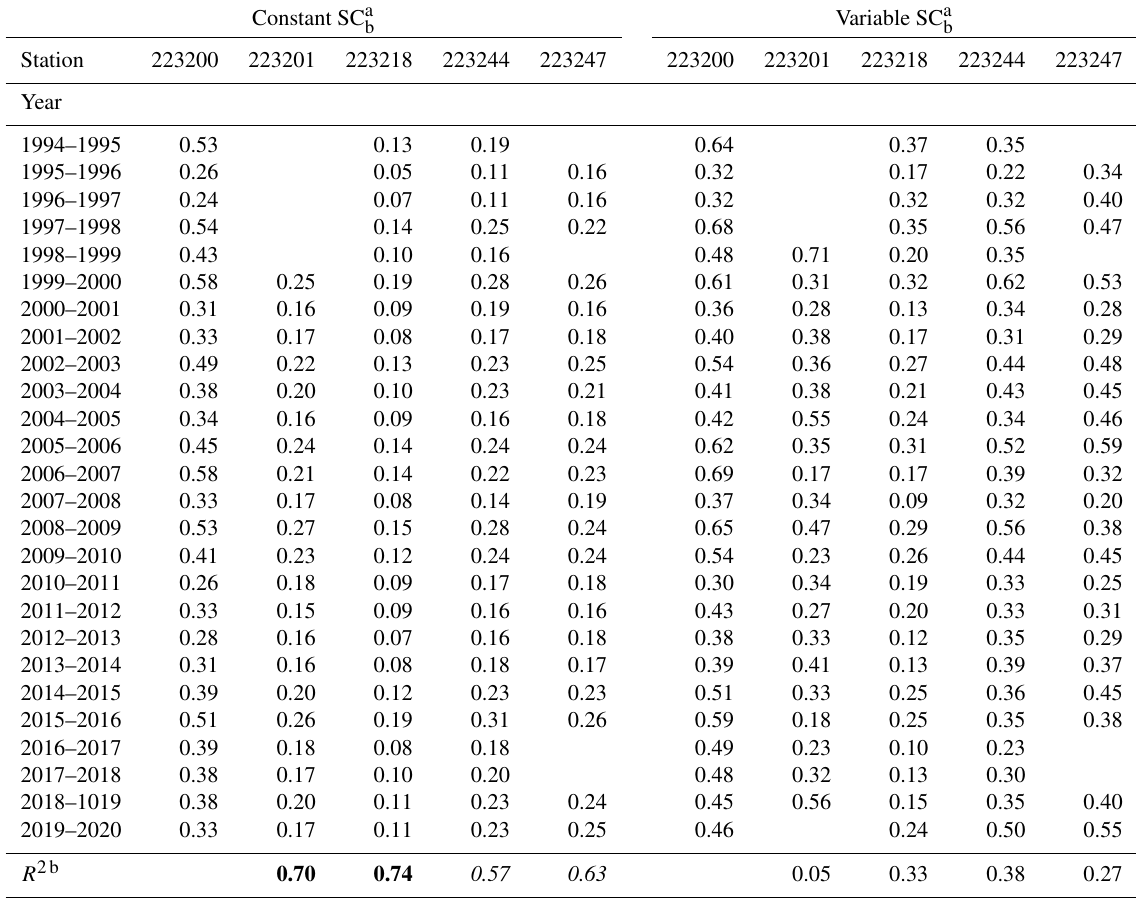
Table 2. Comparison of annual BFI estimates from the Barwon River. Constant SC a